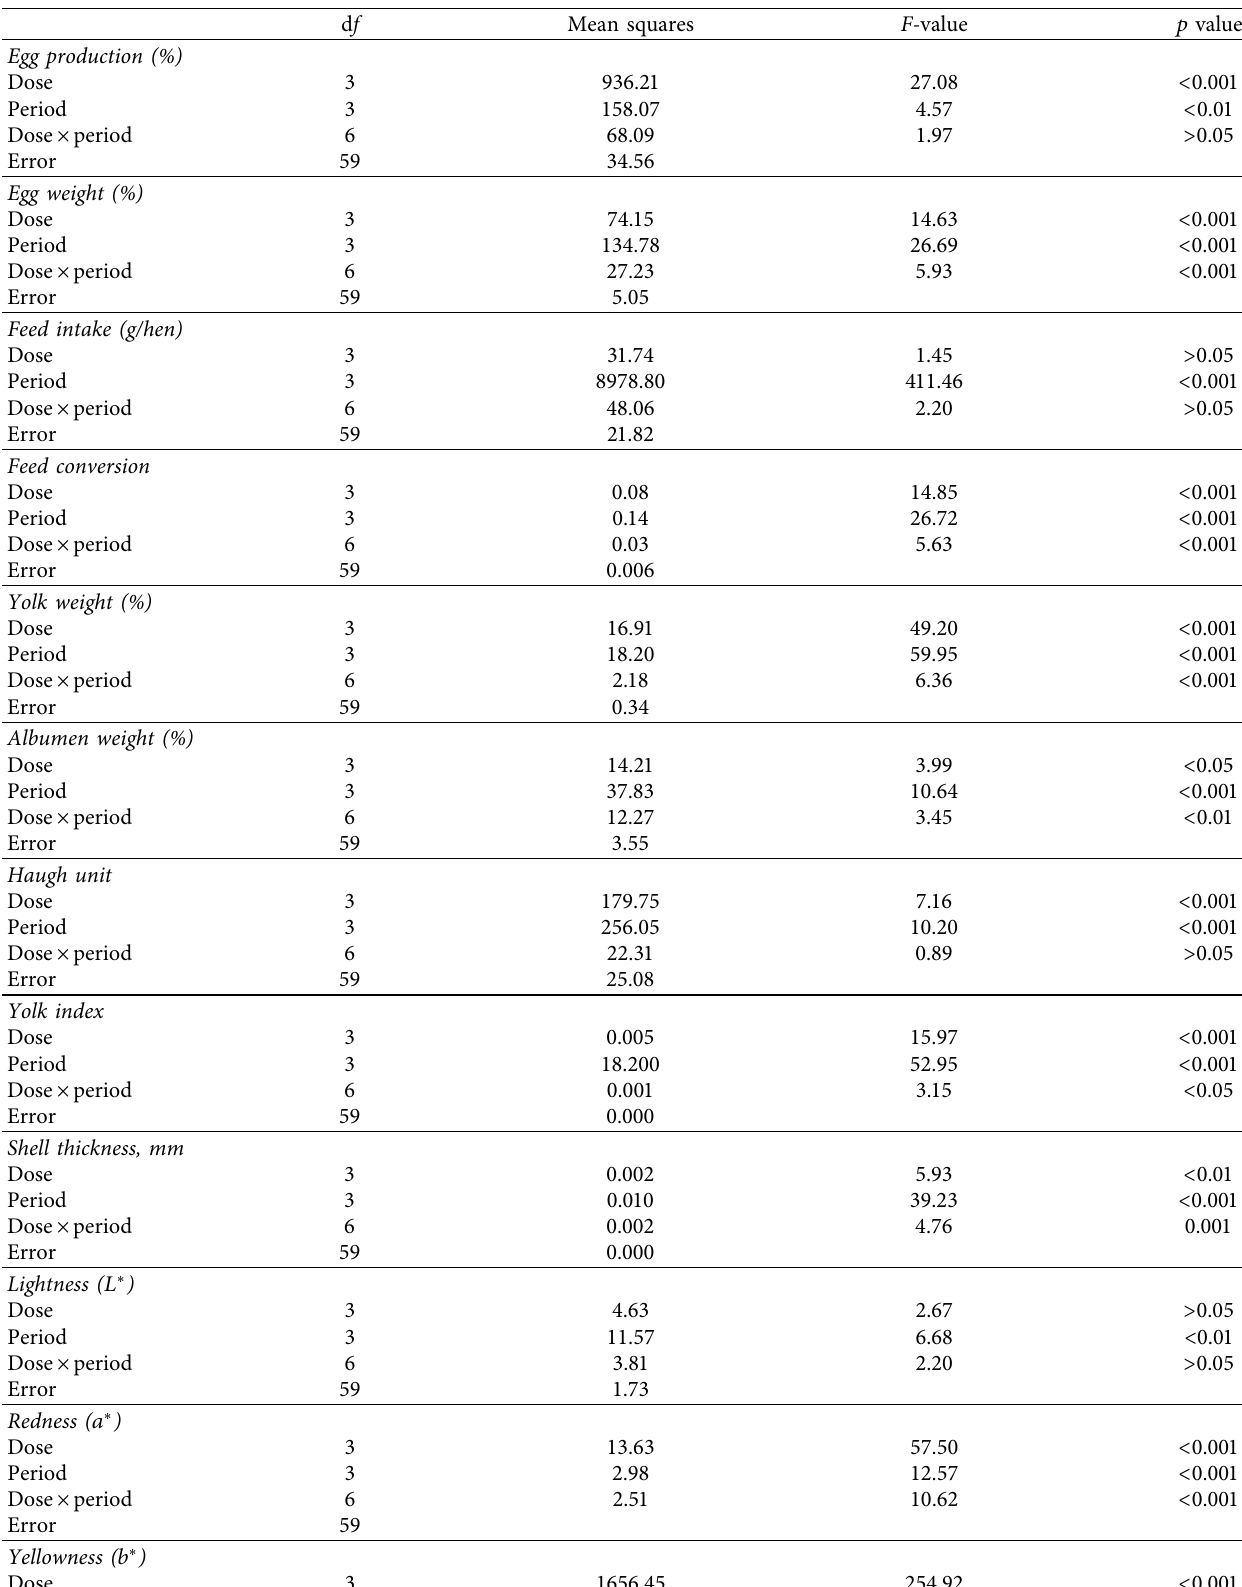
Table 6: Analysis of variance for the efect of nonindustrial hemp seed incorporation in the diet of laying hens on zootechnical performance, physical egg quality, and yolk color measurement during the experimental period. d f Mean